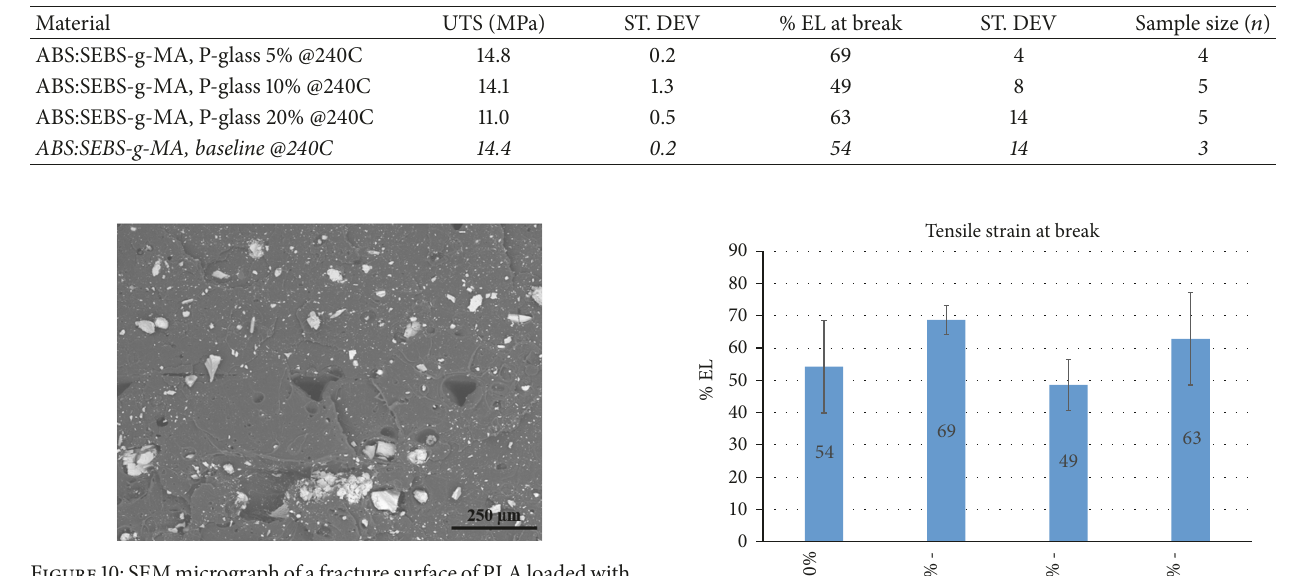
Figure10:SEMmicrographofafracturesurfaceofPLAloadedwith P-glass at 10% by weight.